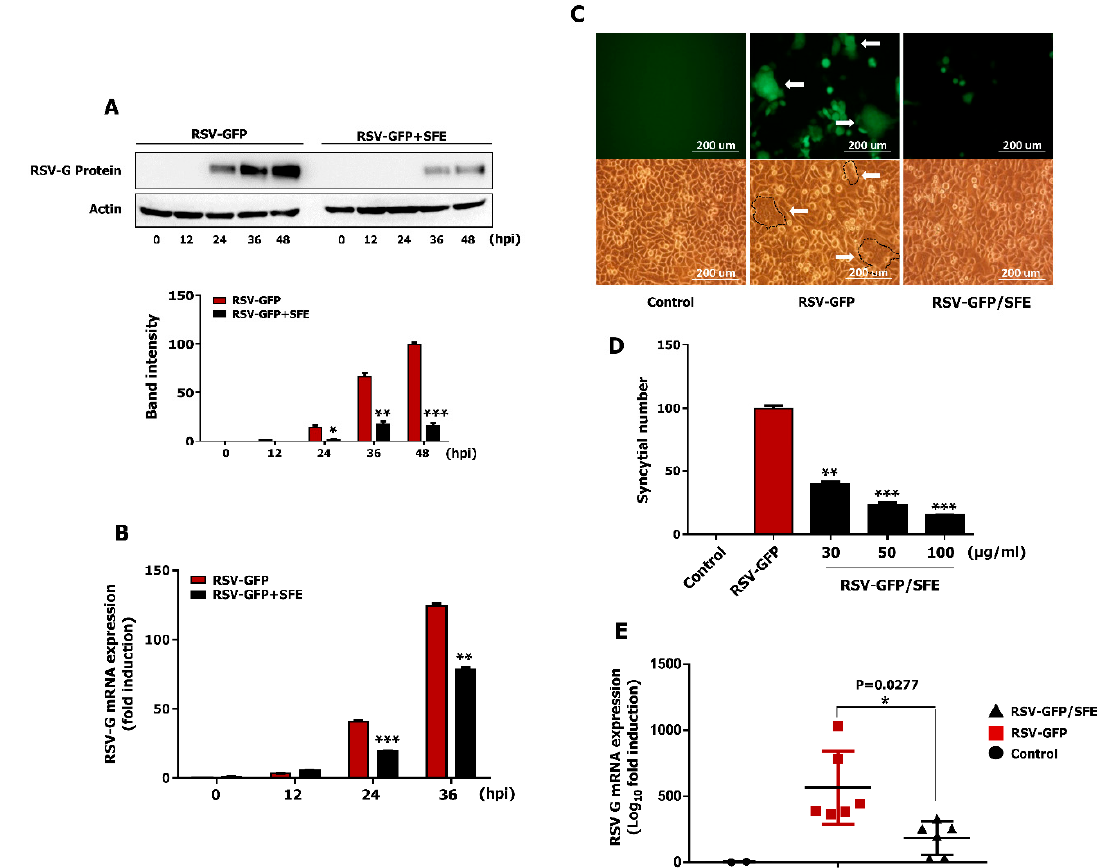
Figure 3. SFE abrogates viral gene transcription, protein translation, and syncytial formation in HEp2 cells and reduces RSV–GFP replication in mice model. Hep2 cells (3 × 10 5 cell/well) were added to the six-well cell culture plate. After 12 h, a monolayer of HEp2 cells was infected with 0.1 MOI of RSV–GFP in 1% FBS containing media for 2 h. Next, cells were treated with 50 µ g/mL of SFE. ( A ) RSV-G protein expression level was evaluated by immunoblot analysis assay with the cell lysates collected at indicated time points. RSV-G protein intensity was determined compared to β -actin. ( B ) Transcription levels of RSV-G protein at indicated time points were evaluated by qRT-PCR analysis. GAPDH was used for the normalization. ( C ) Cell and GFP images were taken at 48 hpi to see the syncytial formation inhibition by SFE (400 × magnification), white arrow: cell to cell fusion and syncytial formation in HEp2 cells. ( D ) The syncytial number was counted using image software. ( E ) Five-weeks-old BALB/c mice (RSV–GFP, n = 6, RSV–GFP/SFE, n = 6, Control, n = 2,) were intranasally infected with RSV–GFP (1 × 10 6 PFU/mice) in a total volume of 28 µ L. SFE were orally administrated with the dose of 200 µ L/mice (0.5 mg/mL) at 6, 12, 18, and 24 hpi. The transcription level of RSV-G protein mRNA in the lung tissues of the mice at 5 dpi was determined by qRT-PCR. White arrow: RSV-syncytial formation. Scale bar-200 Mm. Western blot band intensity, mRNA transcription, syncytial number was expressed as the mean ± SD of three independent experiments. In vivo experiments were conducted twice. (* p < 0.05, ** p < 0.01, *** p < 0.001 regarded as significant